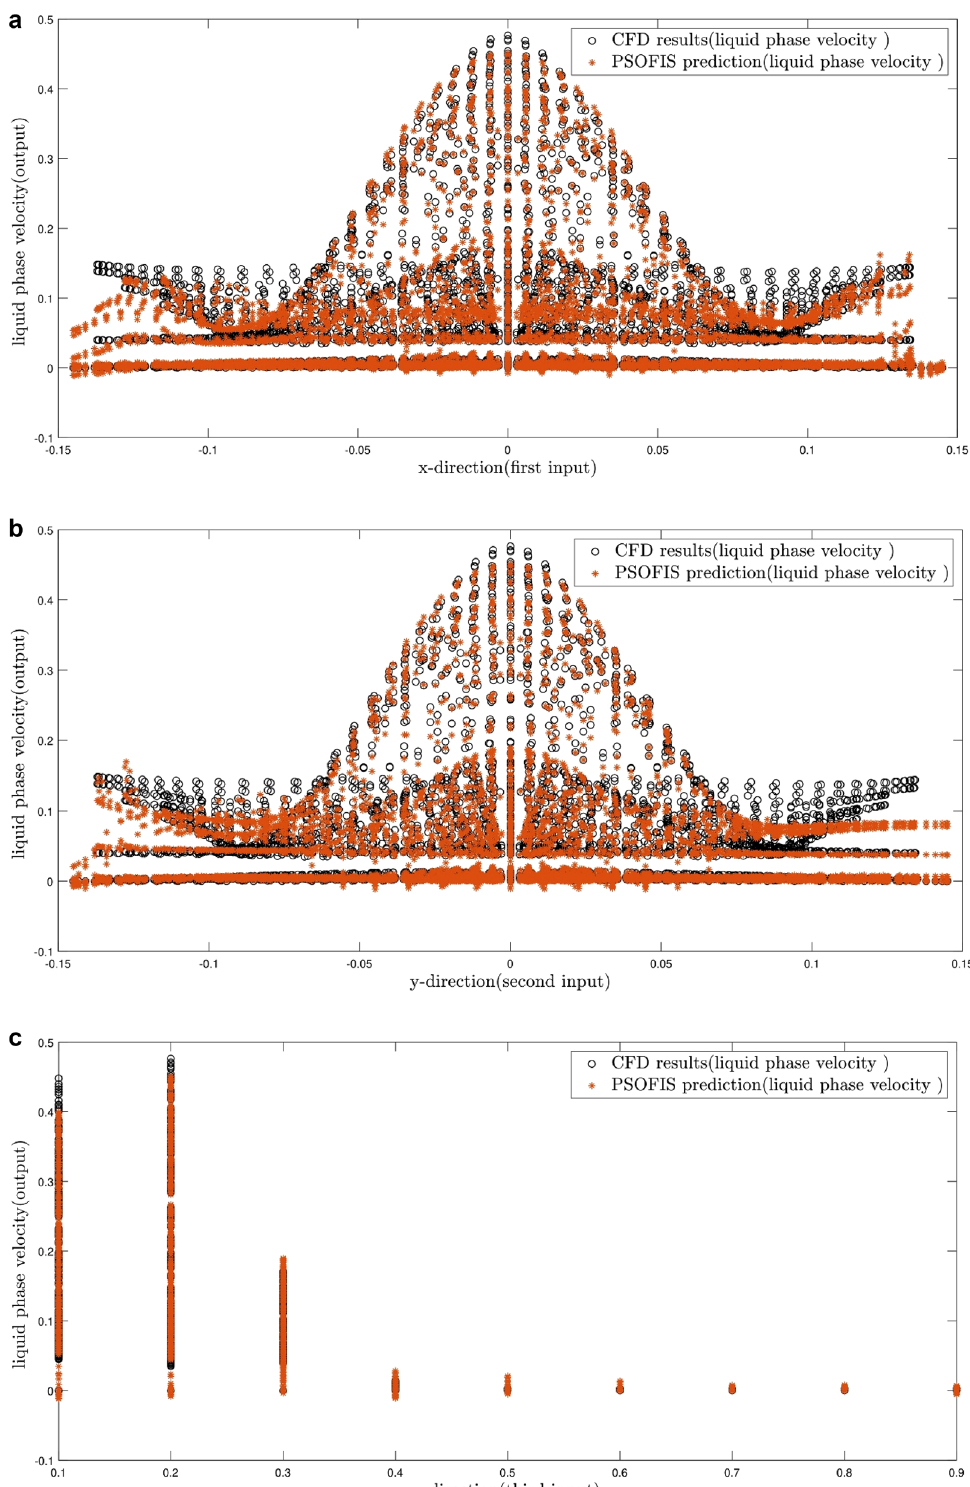
Figure 10. ( a ) Validation of PSOFIS learning process after achieving the highest PSOFIS intelligence based on first input. ( b ) Validation of PSOFIS learning process after achieving the highest PSOFIS intelligence based on second input. ( c ) Validation of PSOFIS learning process after achieving the highest PSOFIS intelligence based on third